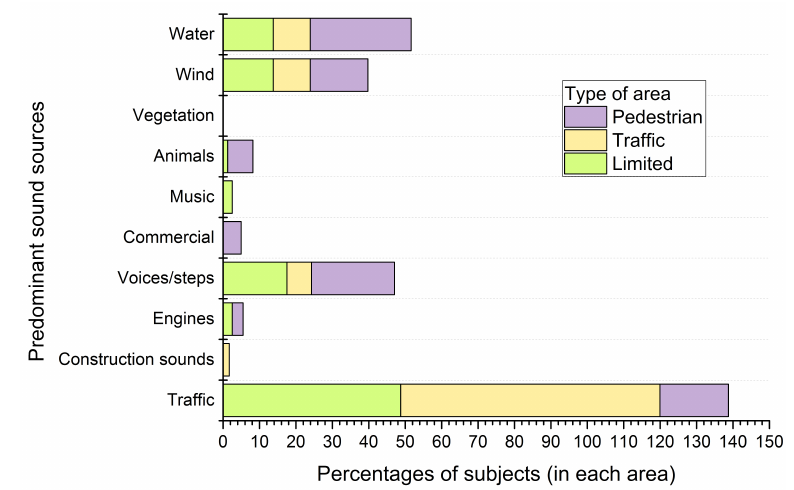
Figure 4. Percentage of subjects that recognized a certain sound source as the predominant one within the three types of areas a priori classified as pedestrian areas, open to road traffic areas and limited traffic areas.